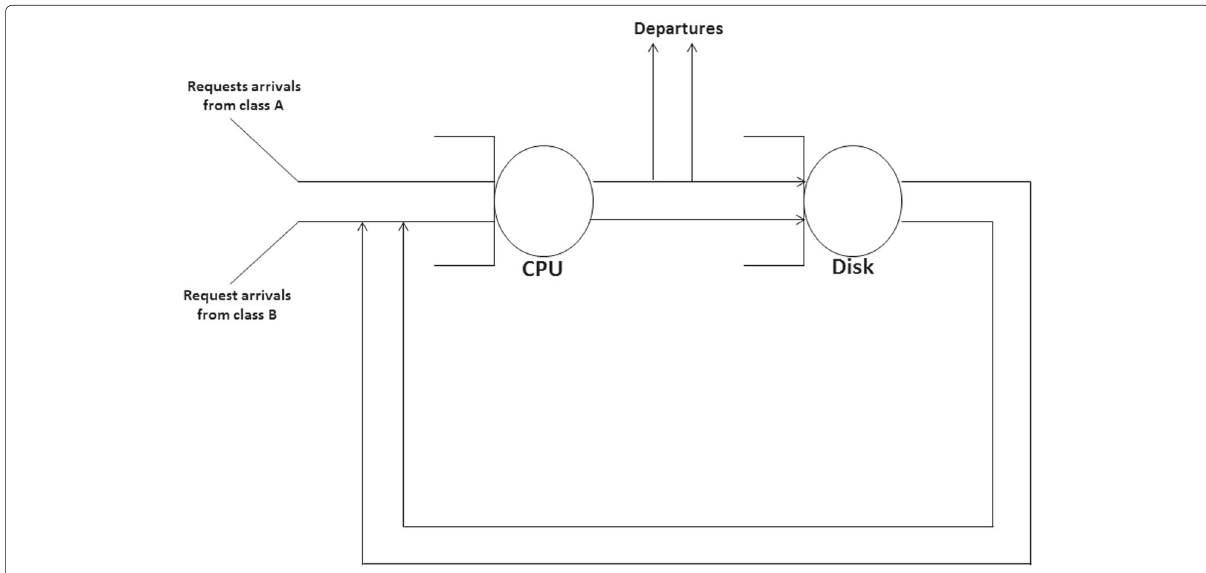
Fig. 5 Open multiclass queuing network